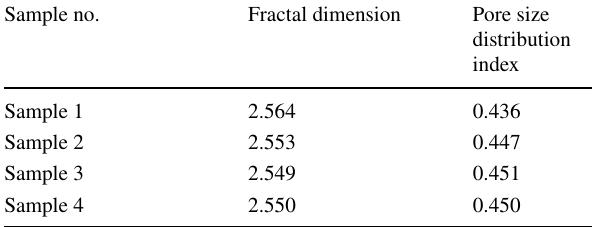
Table 5 Fractal dimension and pore size distribution index Sample